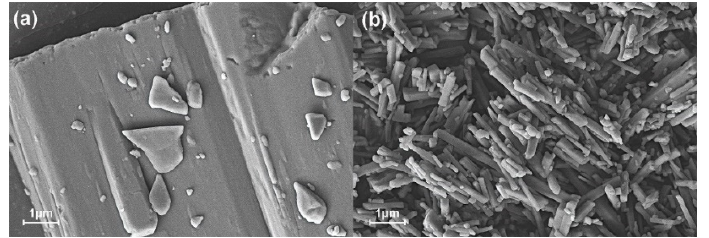
Figure 4. The morphology of raw naringenin ( a ) and NUP ( b ) under a scanning electron microscope.